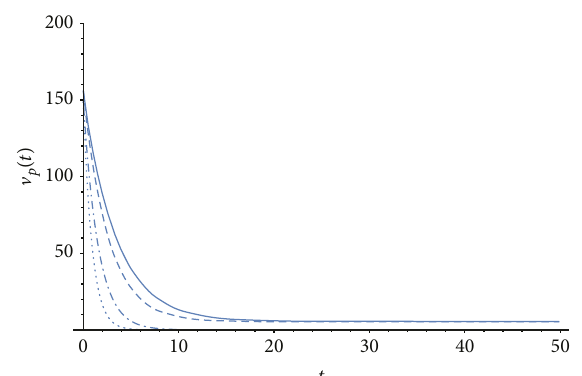
Figure 4: The graph represents the solution behavior for the variable v t (concentration of pathogen virus) versus time t p under di ff erent values of the order of derivative. The solid line, dashed line, dot-dashed line, and dotted line represent solution behavior at ζ = 1, ζ = 0 75, ζ = 0 85 , and ζ = 0 95 , respectively.